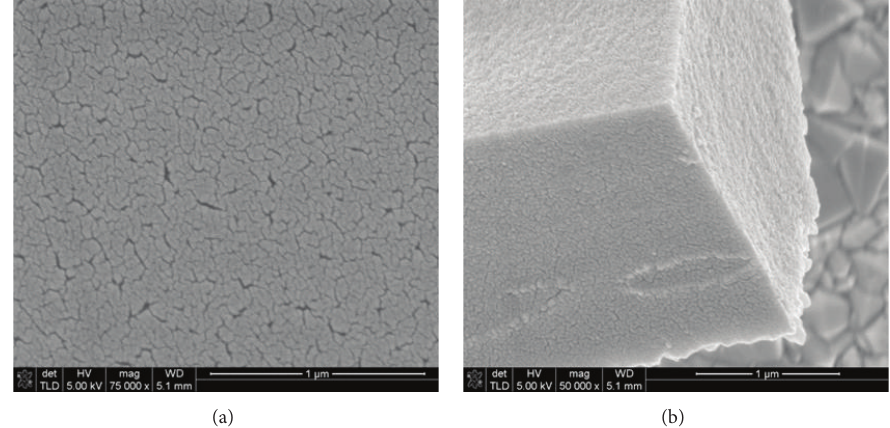
Figure 6: (a) Showing the mesoporosity of the SG photoelectrodes and (b) the view of a SG/3 layers/6 h photoelectrode. The mesoporosity of the film allows good penetration of the electrolyte within the film and it is likely to be responsible for the good photoactivity shown by the SG